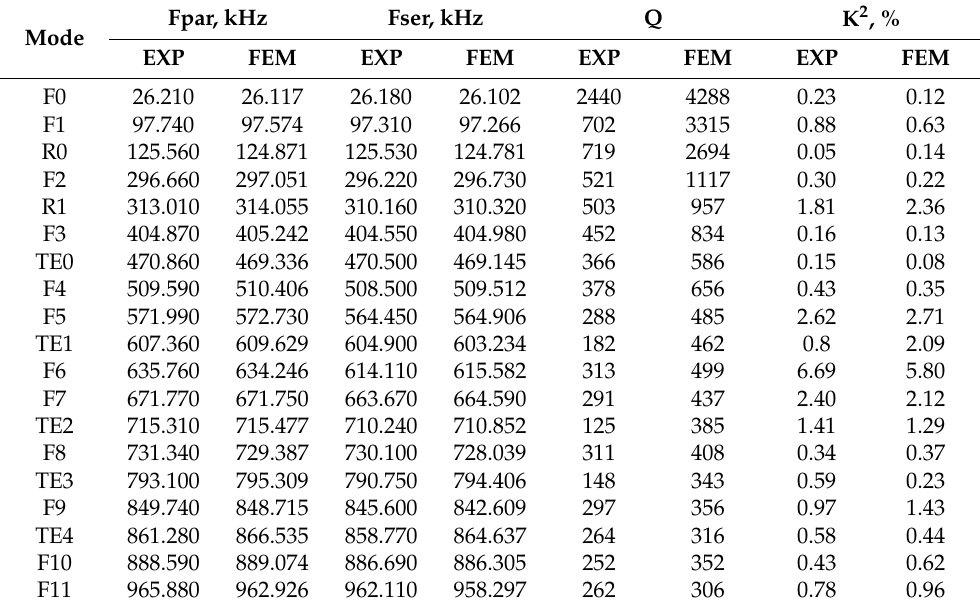
Table 3. The mode name and parameters of 19 observed modes of acoustical oscillations in radial electric field excited piezoelectric resonator under